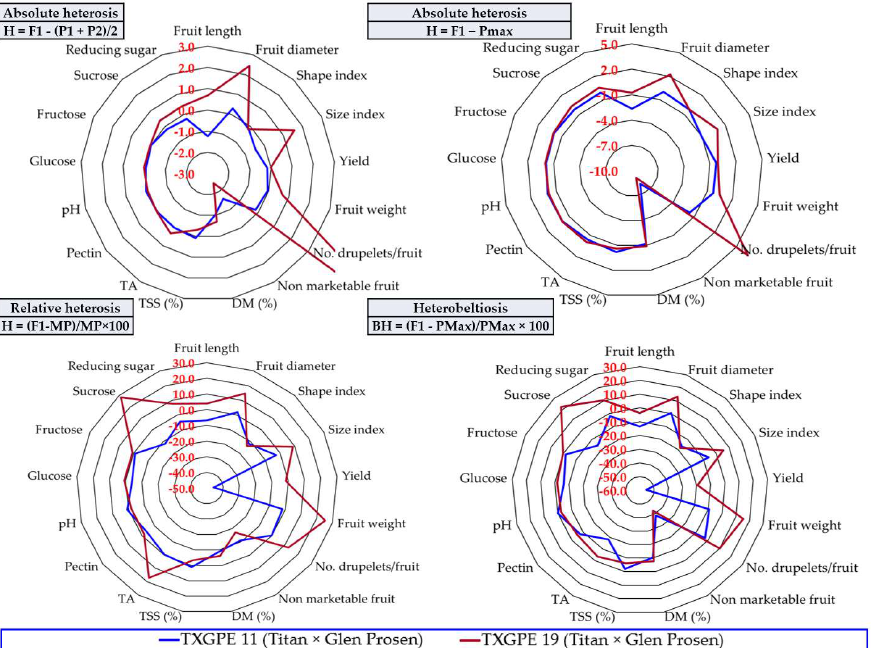
Figure 11. The heterosis effect upon the 17 analyzed characteristics in two promising selections obtained from the hybridization of Titan × Glen Prosen.